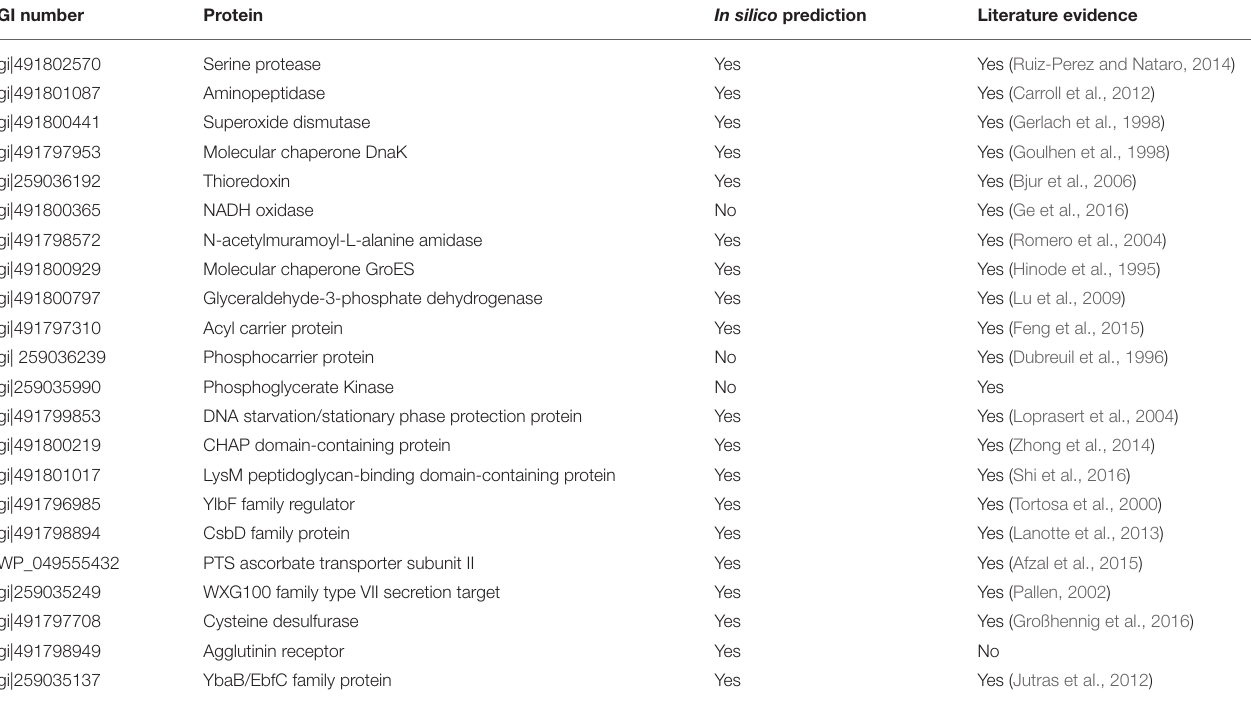
TABLE 2 | Putative virulence factors identified in G. adiacens secretome. GI number Protein In silico